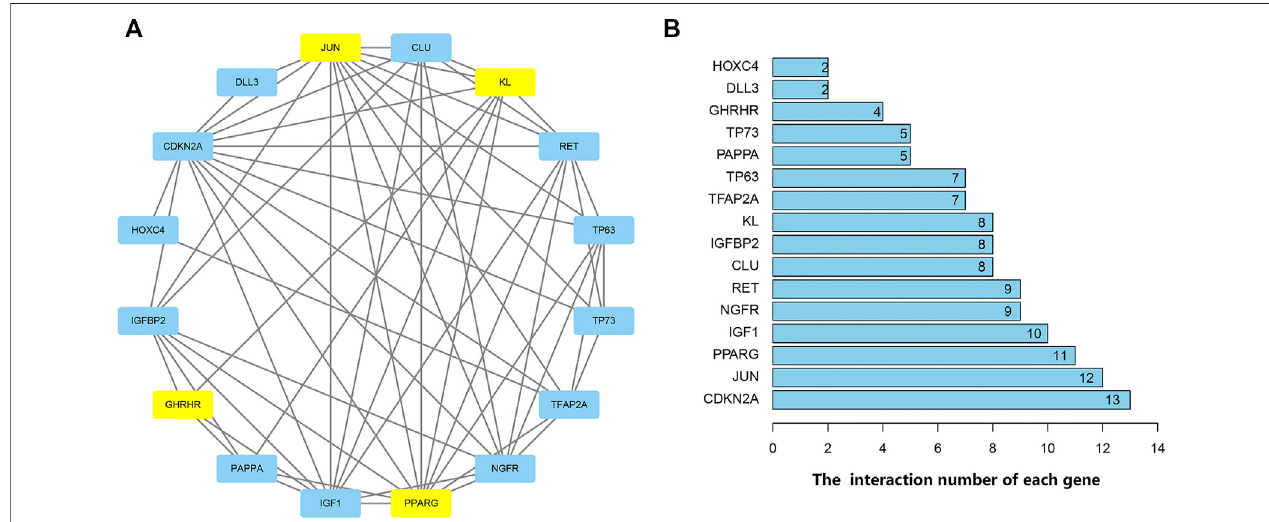
FIGURE 3 | Protein-protein interactions (PPI) analysis the 16 differentially expressed aging-related genes. (A) The PPI among 16 differentially expressed aging- related genes. The blue represents the signi fi cantly up-regulated genes and the yellow suggests the signi fi cantly down-regulated genes. (B) The interaction number of each differentially expressed aging-related gene.